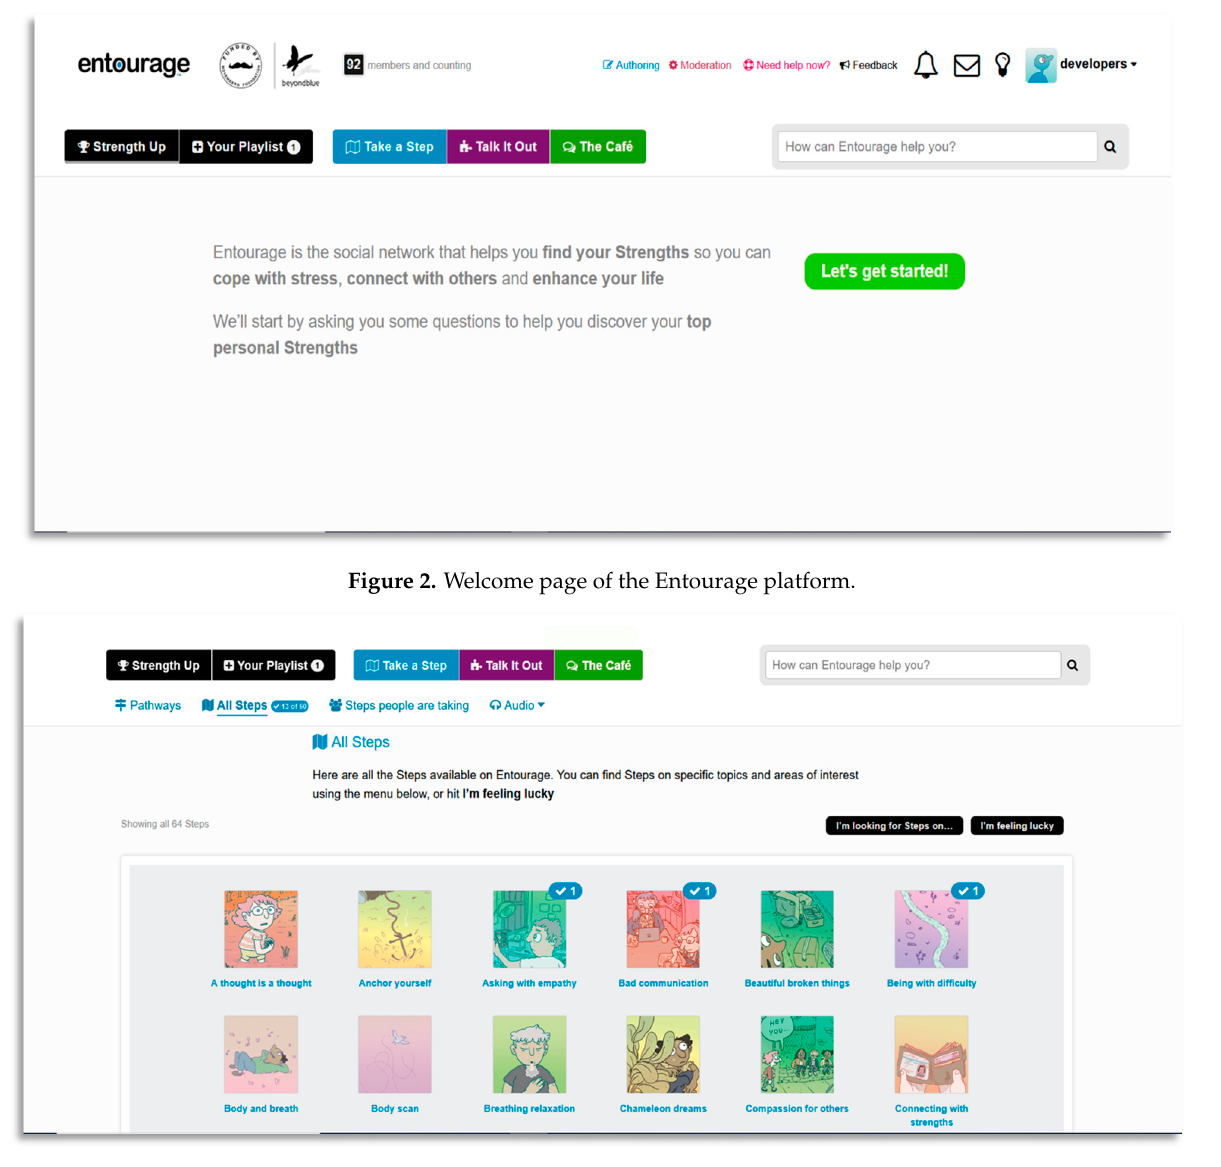
Figure 3. Participants’ view of available therapy “Steps” within the Entourage